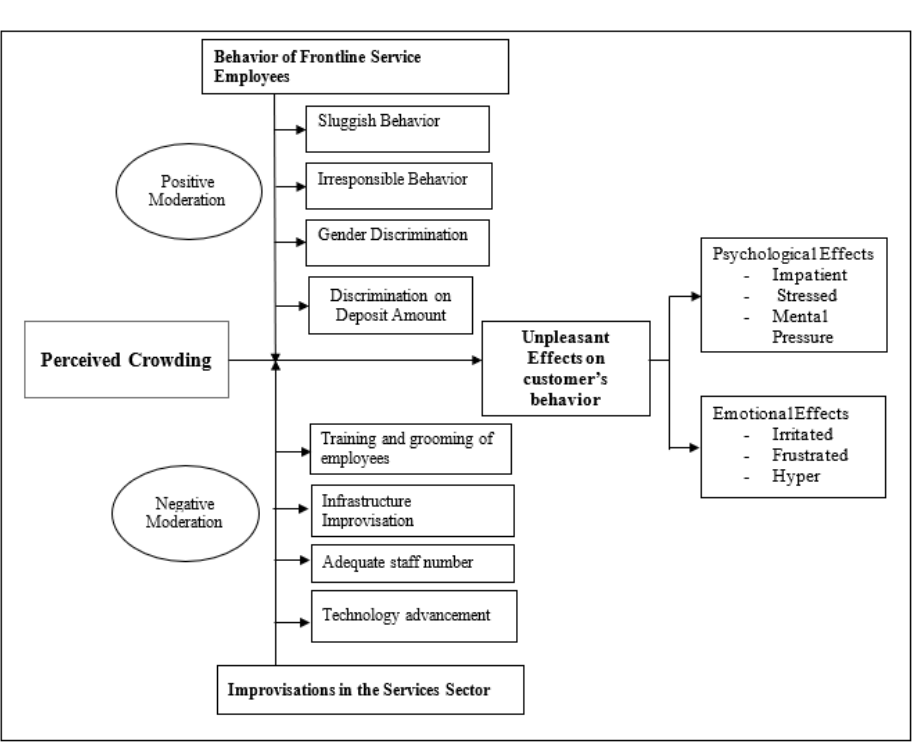
Figure 4: Conceptual Framework for Perceived Crowding and its effects